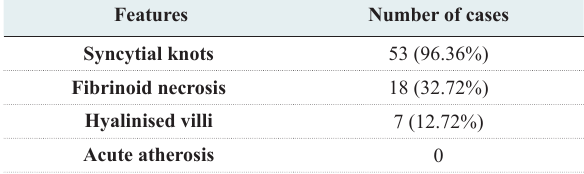
Table 4: Stromal Pathology